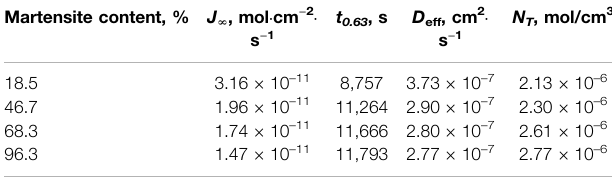
TABLE 3 | Hydrogen permeation parameters of DP